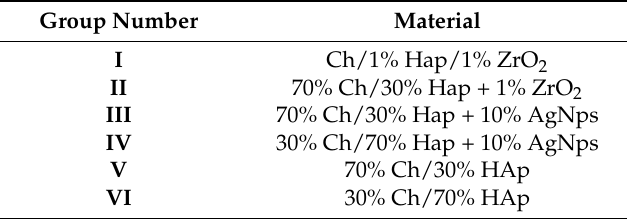
Table 1. Classification of the prepared samples compositions: Ch-chitosan, HAp-hydroxyappatite, Ag Nps-silver